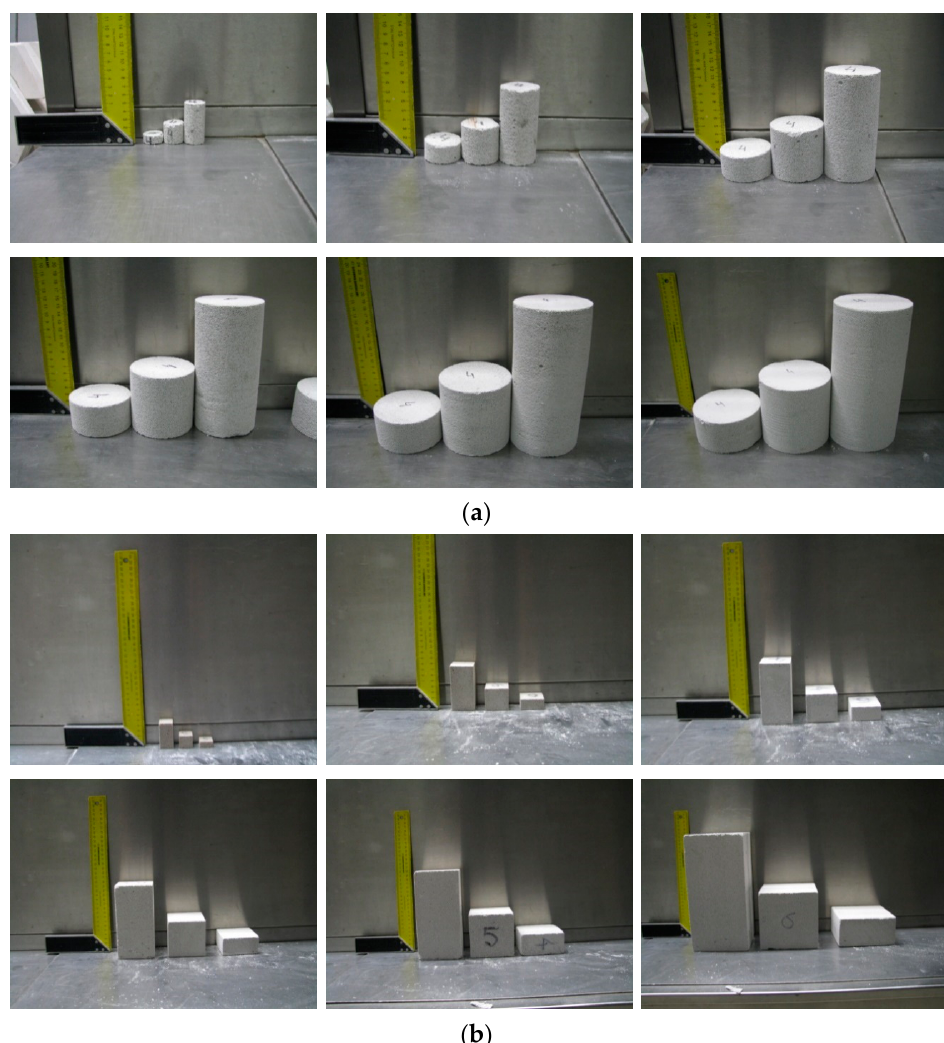
Figure 1. Specimens before tests [27]: ( a ) core specimens, and ( b ) cube specimens.